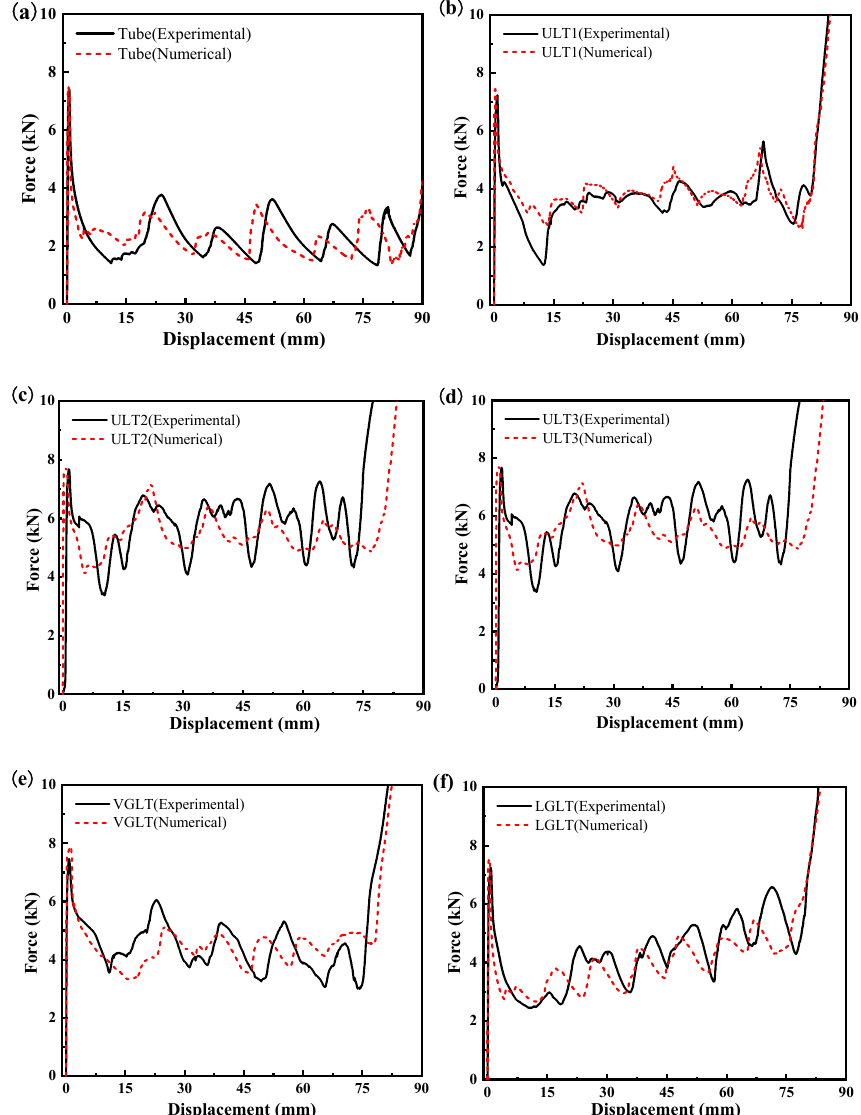
Figure 10. Force–displacement curves of specimen experiments and simulations: ( a ) ULT1, ( b ) ULT1, ( c ) ULT2, ( d ) ULT3, ( e ) VGLT, ( f ) LGLT.